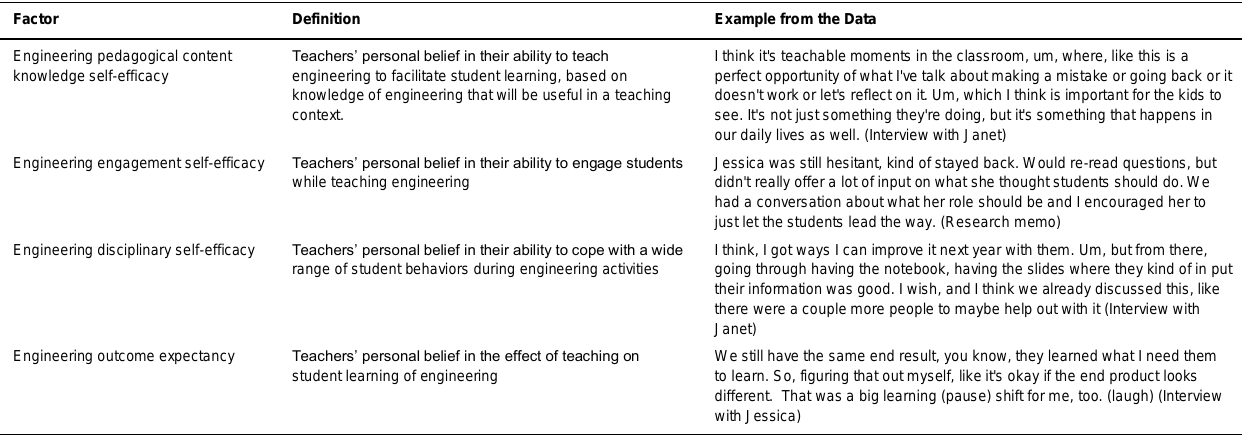
Table 2. Factors of Teaching Engineering Self-Efficacy Factor Definition Example from the